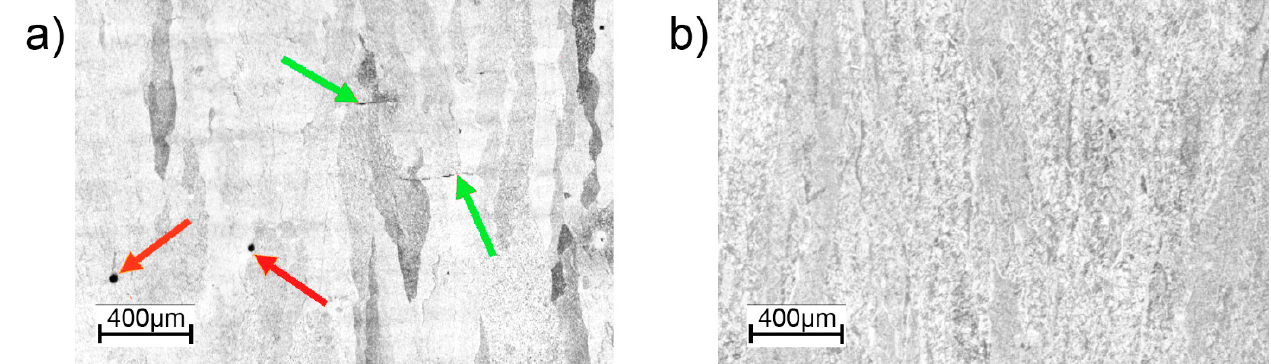
Figure 10. Microstructure of PBF-EB/Ti-55511: ( a ) as-built, ( b ) HIP. Optical microscope. Arrows: red—gas pores, green—lack-of-fusion defect.